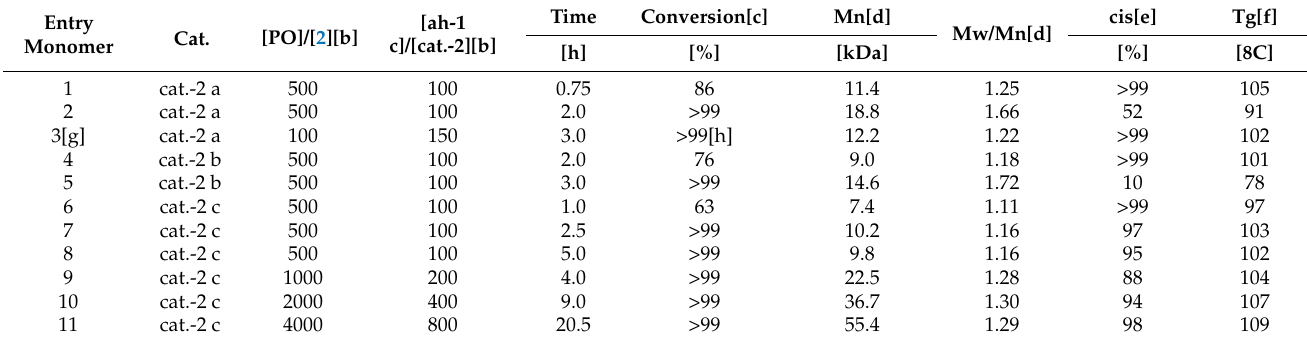
Table 9. Mediated copolymerization of PO, time conversion, MW and Tg